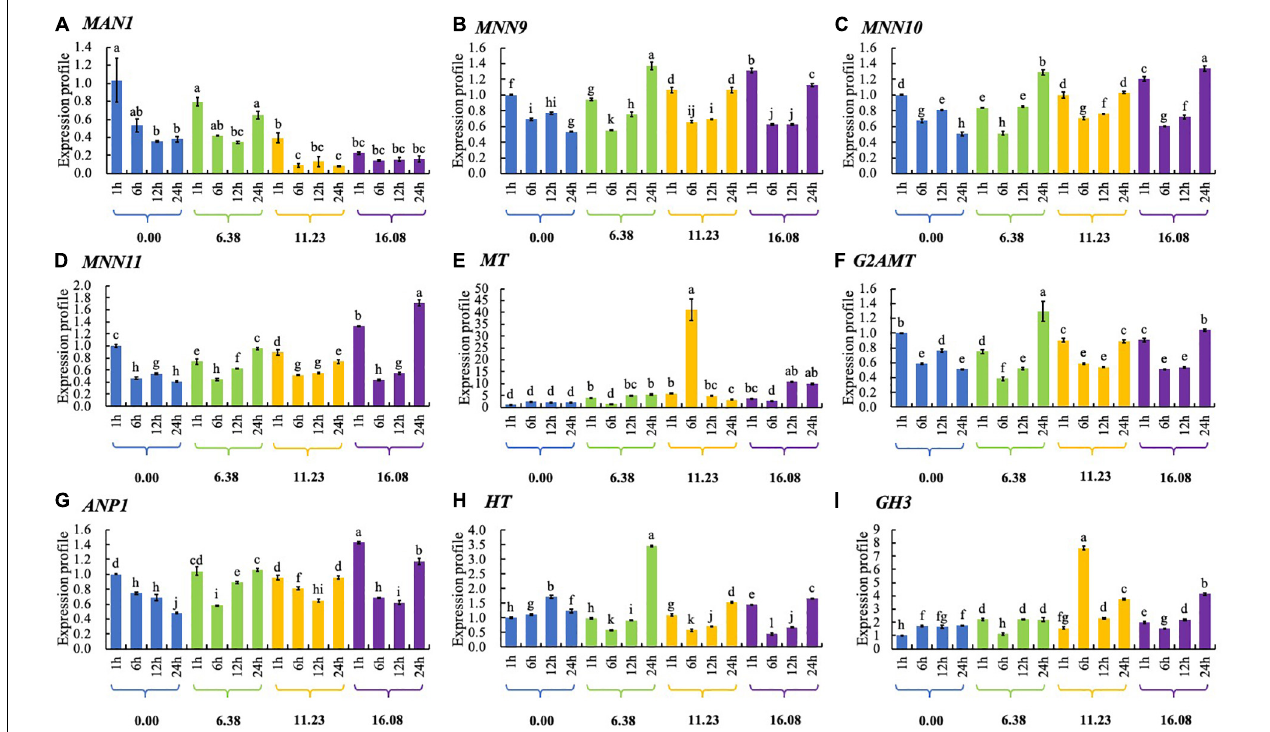
FIGURE 9 | The expression of genes related to N -glycan biosynthesis in Ps. camelliae-sinensis strain GZHS-2017-010 hyphae treated with phenazine-1-carboxylic acid (PCA). (A) MAN1 : Mannosyl-oligosaccharide 1,2-alpha-mannosidase ; (B) MNN9 : Mannan polymerase complexes subunit MNN9 ; (C) MNN10 : Mannan polymerase II complex MNN10 subunit ; (D) MNN11 : Mannan polymerase II complex MNN11 subunit ; (E) MT : Mannosyl transferase ; (F) G2AMT : Glycolipid 2-alpha-mannosyltransferase ; (G) ANP1 : Mannan polymerase II complex ANP1 subunit ; (H) HT : Hexosyl transferase ; and (I) GH3 : Glycoside hydrolase 3 . A shared different lowercase letters showed no significant difference, P > 0.05.